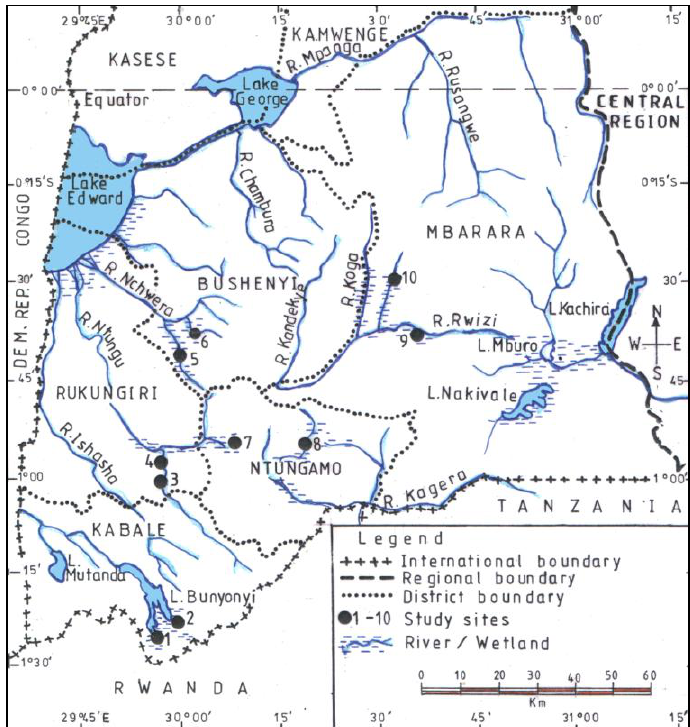
Fig. 3. Location of the study areas in the Western Region of Uganda,